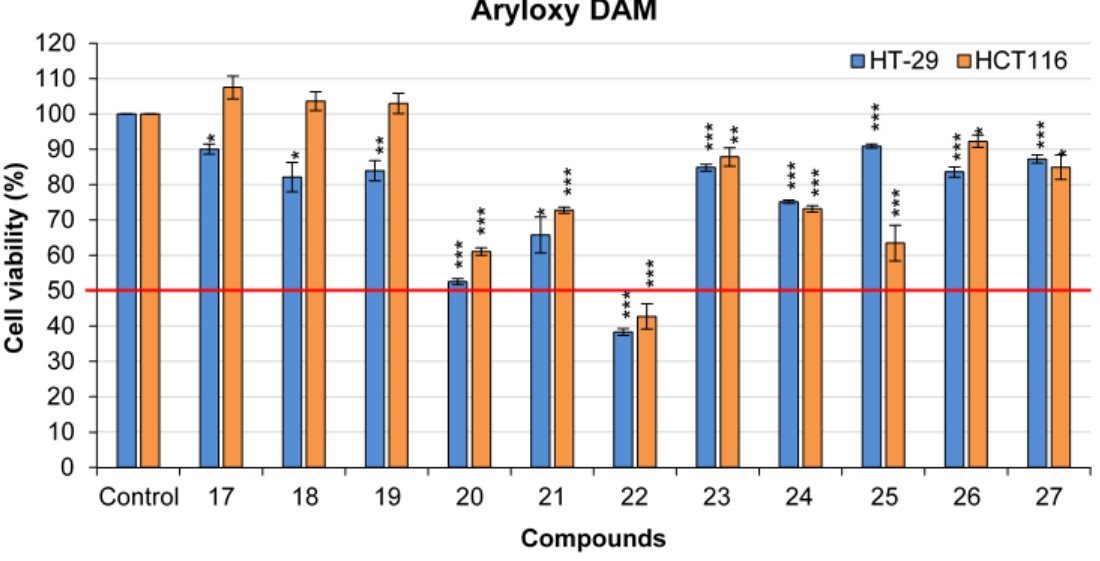
Figure 4. Screening of aryloxyDAM series on human HT-29 and HCT116 CRC cell lines viability. Cell viability (%) after exposure to the DAM was measured by MTT assay. Compounds 17–27 were assayed at 50 µ M for 48 h. Each chart represents the mean percentage ± SEM from at least three independent experiments (n = 3). Cell viability lower than 50% was considered cytotoxic. * p < 0.05; ** p < 0.01 and *** p < 0.001 significantly different from the control. Eleven olefinic DAM ( 6a, 7a-b, 8a, 9b, 10a-b, 12a, 13a, 14a, 15a ) displayed a cell viability lower of 50% for HT-29 and while only six compounds of this series ( 6a, 10a, 12a, 13a, 13b, 14a ) displayed cell viability lower of 50% for HCT116 (Figure 3). For the aryloxy DAM series, only compound 22 for HT-29 and HCT116 cells displayed a cell viability lower of 50% (Figure Table 1. IC 50 values of synthesized compounds against the human CRC cell lines HT-29 and HCT116. a IC 50 values (µM) are indicated as the mean ± SEM of at least three independent experi- ments. b HT-29 and HCT116 cells were treated with different concentrations of the compounds for 48 h. Cell viability was measured by the MTT assay as described in the Experimental Section.